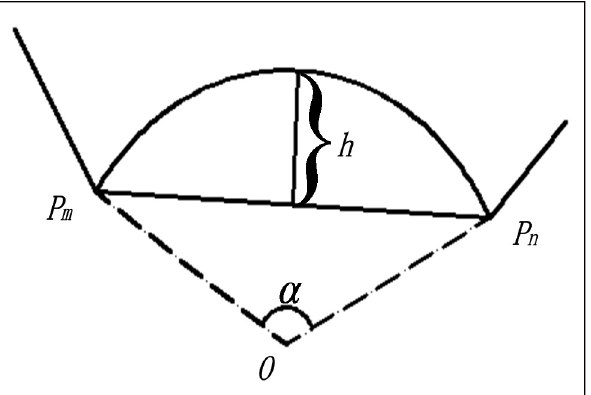
PP as one of the convex